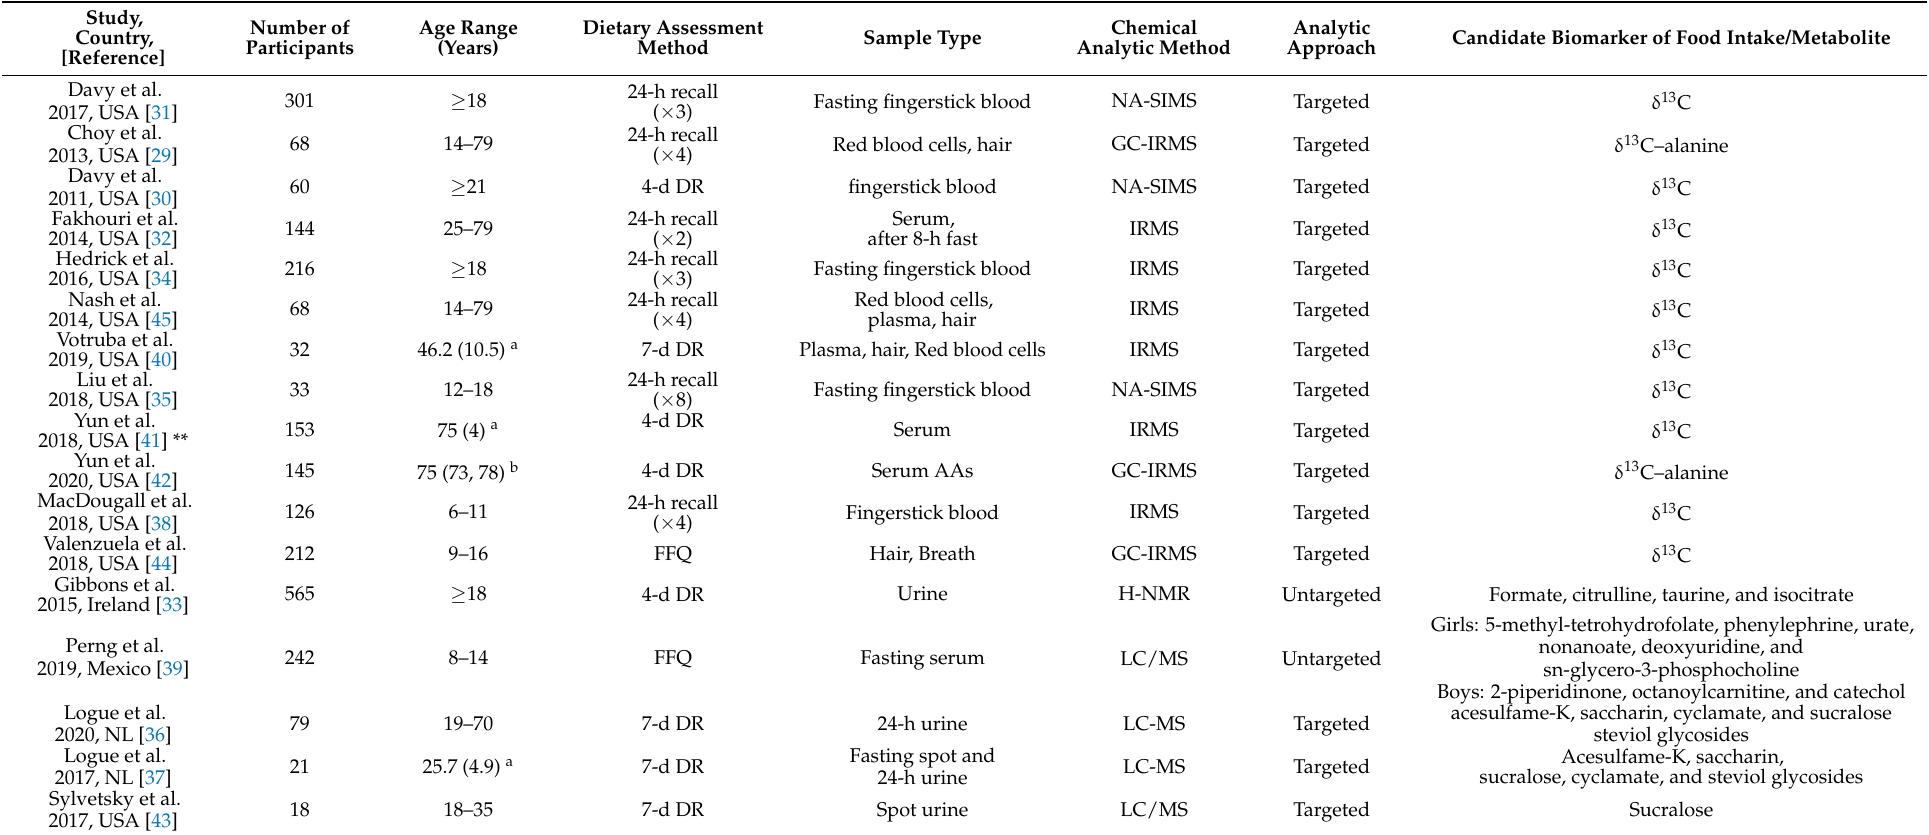
Table 1. Studies on the association between consumption and potential candidate biomarkers for sugar- and low-calorie sweetened